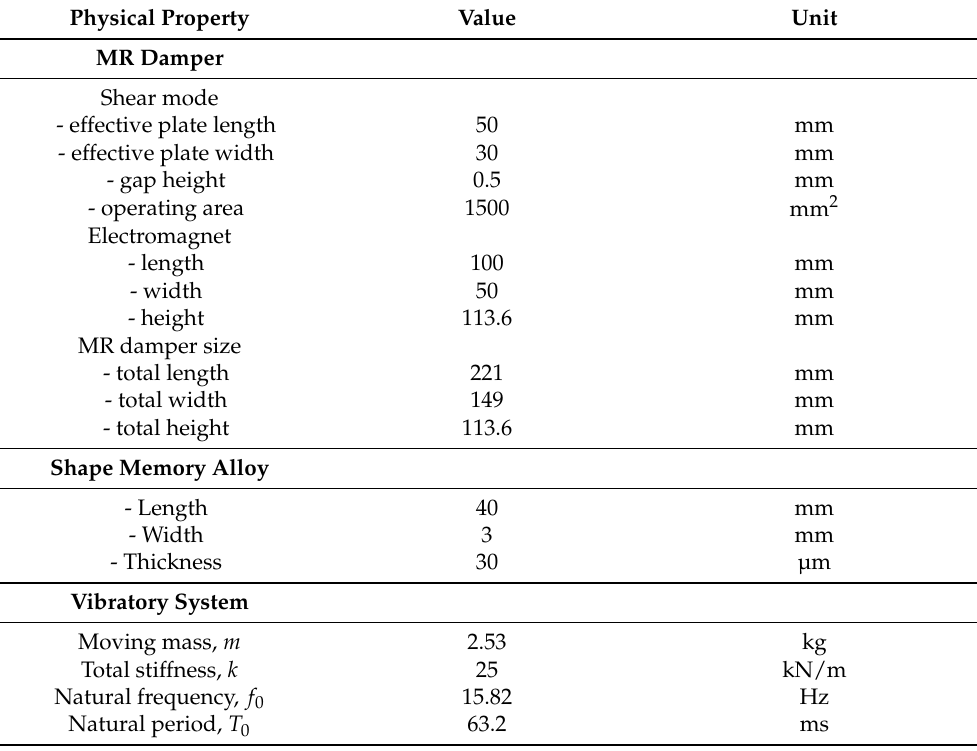
Figure 2. Experimental setup for investigating the proposed hybrid damper concept in dissipating the energy from shock loading. Table 2. Parameters of each damper element and the vibratory system in the experimental